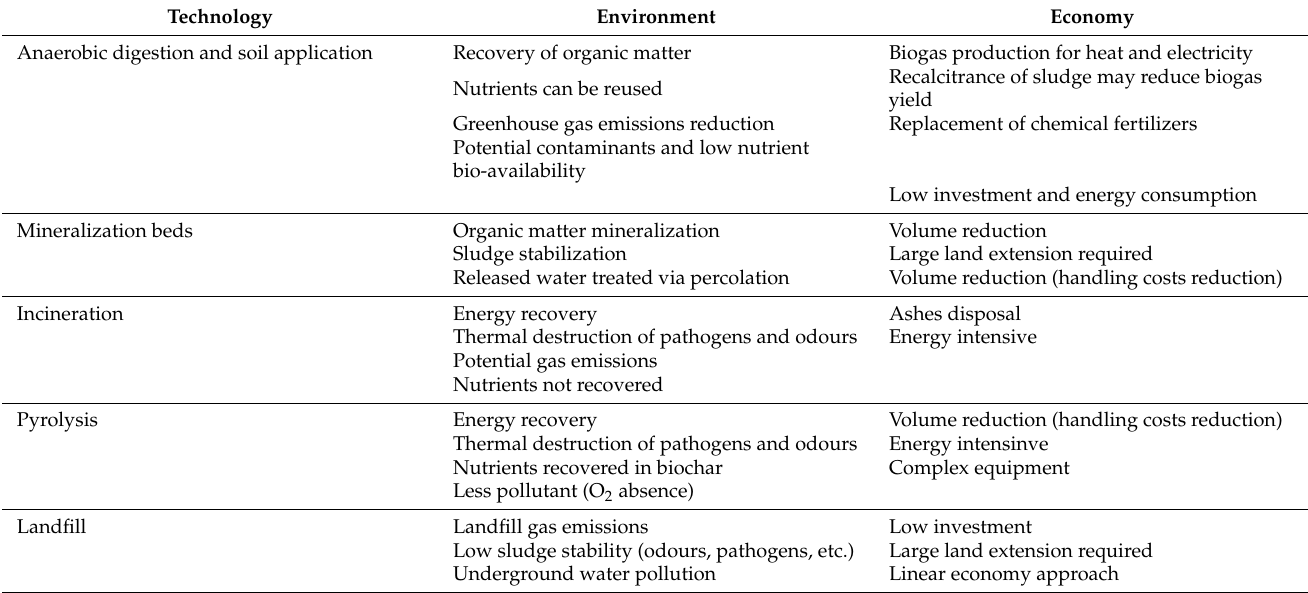
Table 4. Summary of the economic and environmental aspects of different sludge management strategies.